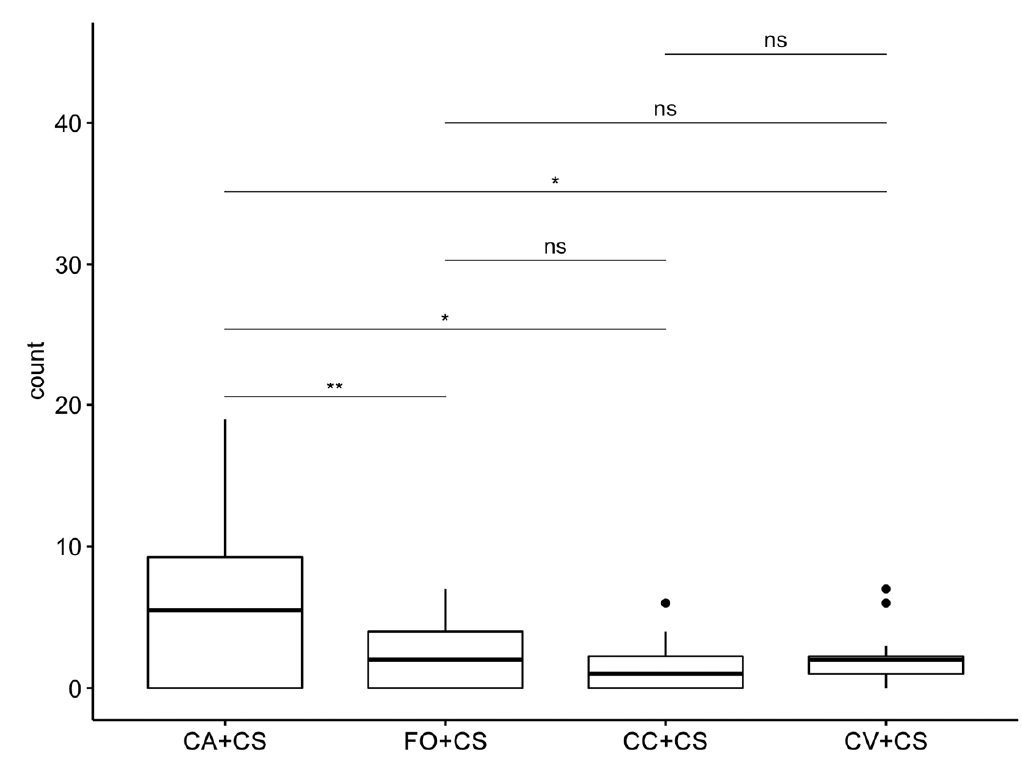
Figure 1. Preference response of Aphis gossypii toward the different combinations, i.e., number of leaves with presence of aphids per plant. Bioassays were carried out on the Citrus sinensis (CS) plants grafted on the four different rootstocks studied. CV: Volkamer lemon; FO: Forner ‐ Alcaide no. 5; CC: Carrizo citrange; CA: Citrus aurantium . Asterisks indicate significant differences among the treatments (* p < 0.05; ** p < 0.01; ANOVA, followed by Tukey’s test). The values are reported in